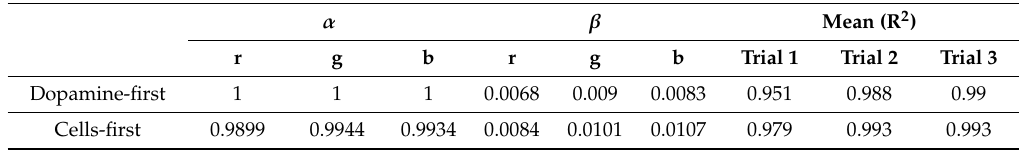
Table 3. The values of the coe ffi cients in (5) and the mean of the coe ffi cient of determination (R 2 ) of each red, green and blue (RGB) intensity for each